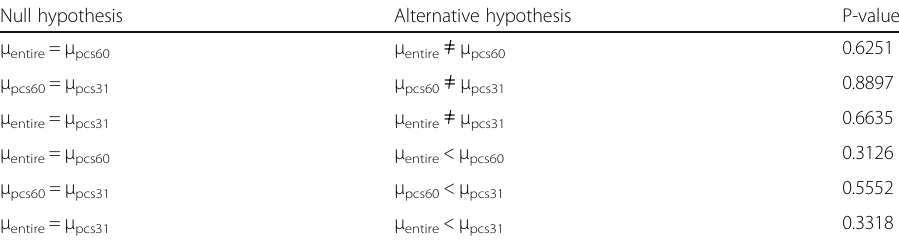
Table 9 Comparison of simulation results from DNN classifiers for three data sets Null hypothesis Alternative hypothesis P-value μ μ entire = pcs60 μ μ pcs60 = pcs31